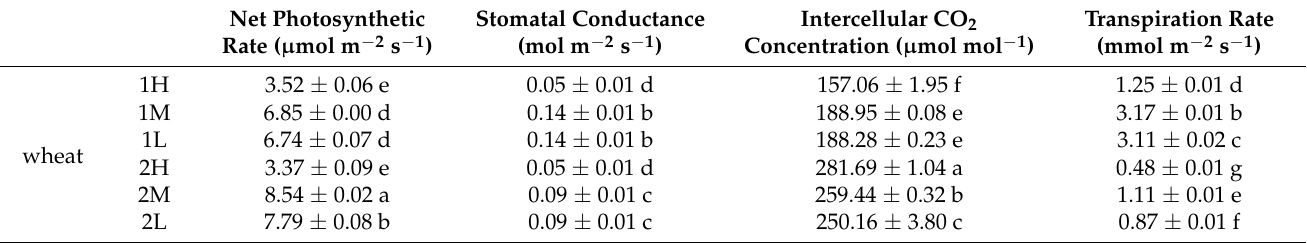
Table 2. The photosynthetic parameters of wheat seedlings under different light conditions. Net Photosynthetic